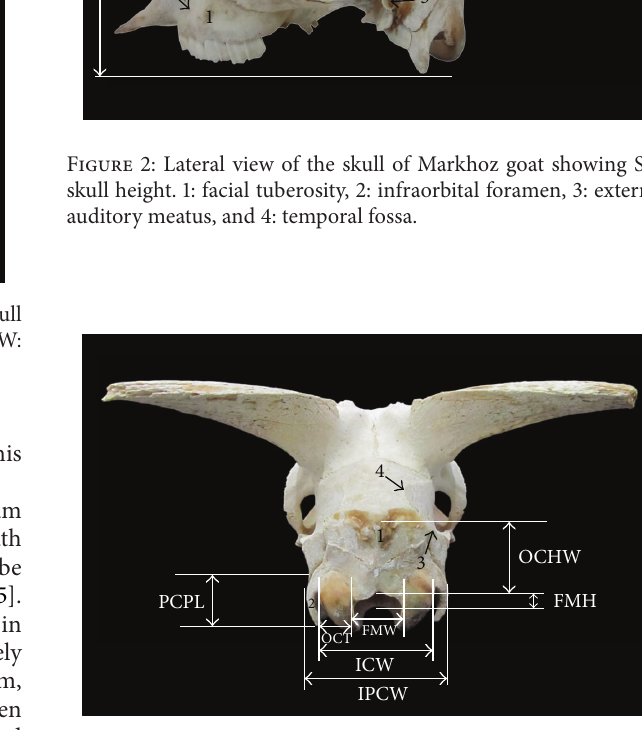
Figure 3: Caudal view of the skull of Markhoz goat showing FMH: foramen magnum height, FMW: foramen magnum width, ICW: intercondylar width, IPCW: interparacondylar width, OCT: occip- ital condyle thickness, and PCPL: paracondylar process length. 1: externaloccipitalprotuberance,2:paracondylarprocess,3:temporal crest, and 4: temporal